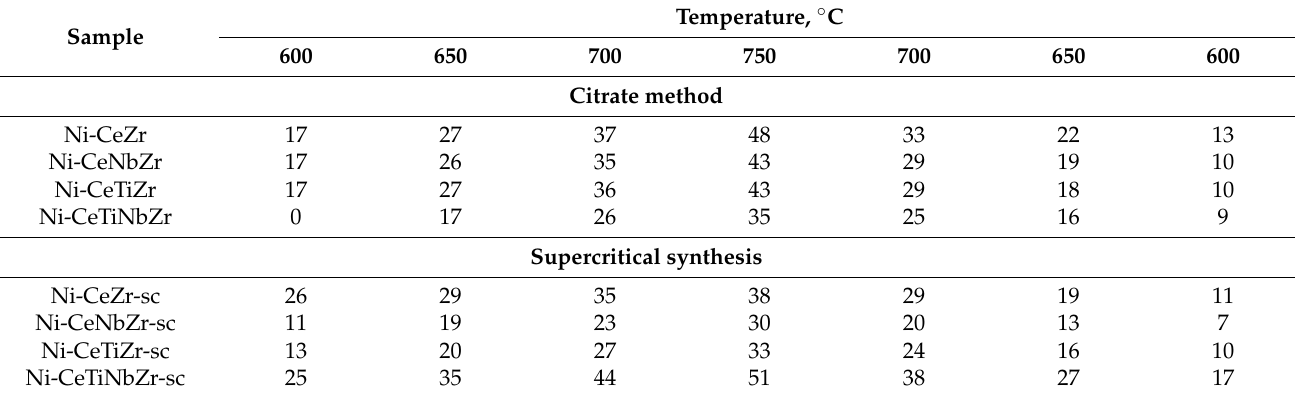
Table 6. Steady-state CH 4 conversions during methane dry reforming at different temperatures.